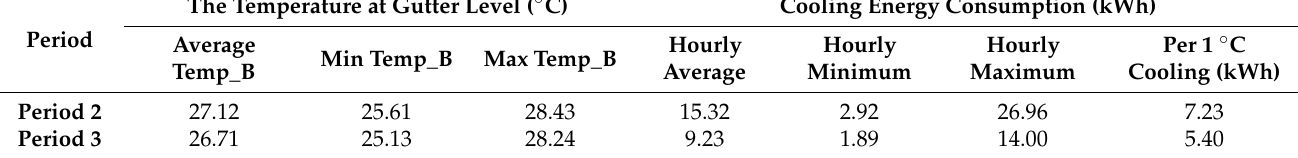
Table 4. Energy Consumption per 1 ◦ C Cooling during Period 2 (Vents closed, Shade screens open) and Period 3 (Vents open, Shade screen